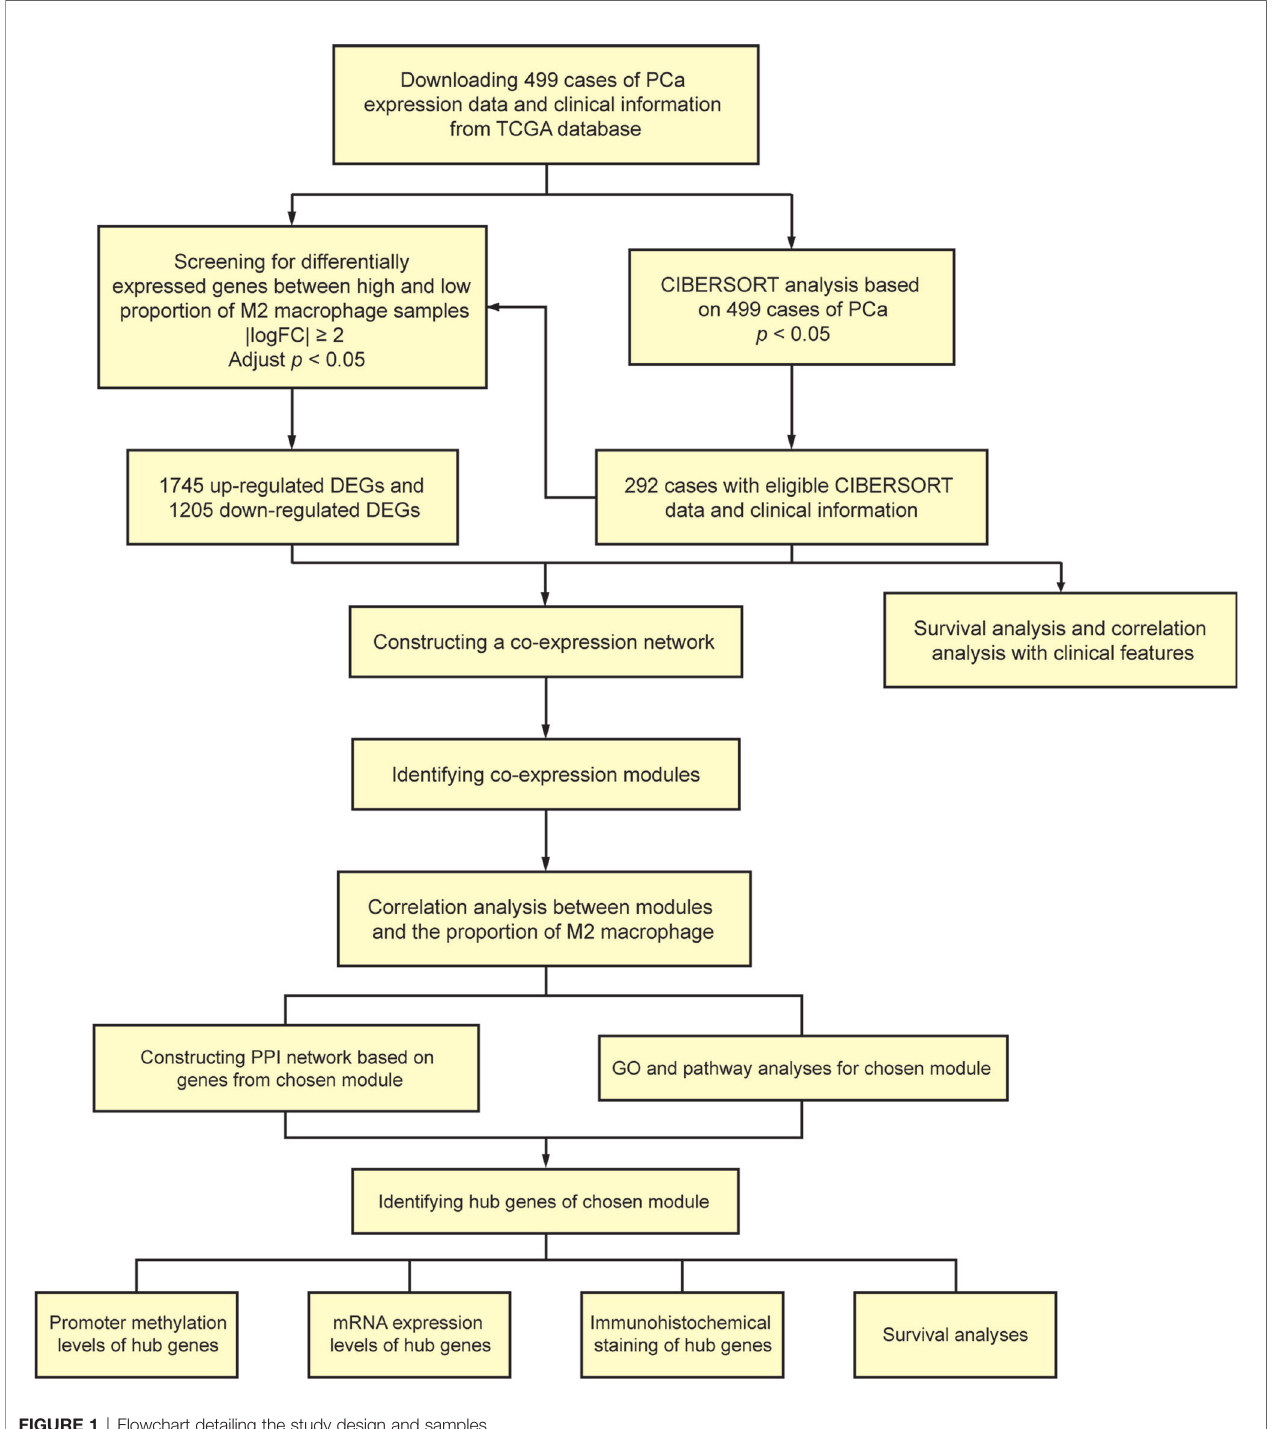
FIGURE 1 | Flowchart detailing the study design and